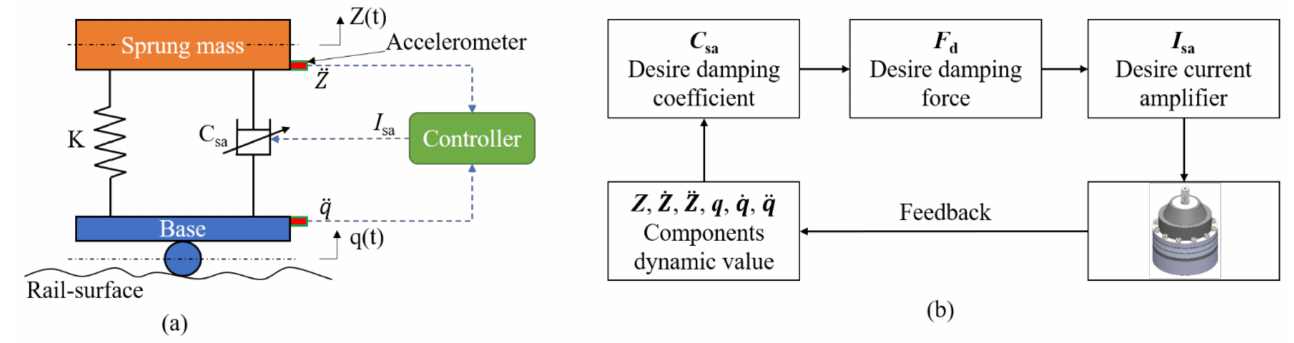
Figure 5. Semi-active controller: ( a ) full control diagram; ( b ) damping force control.